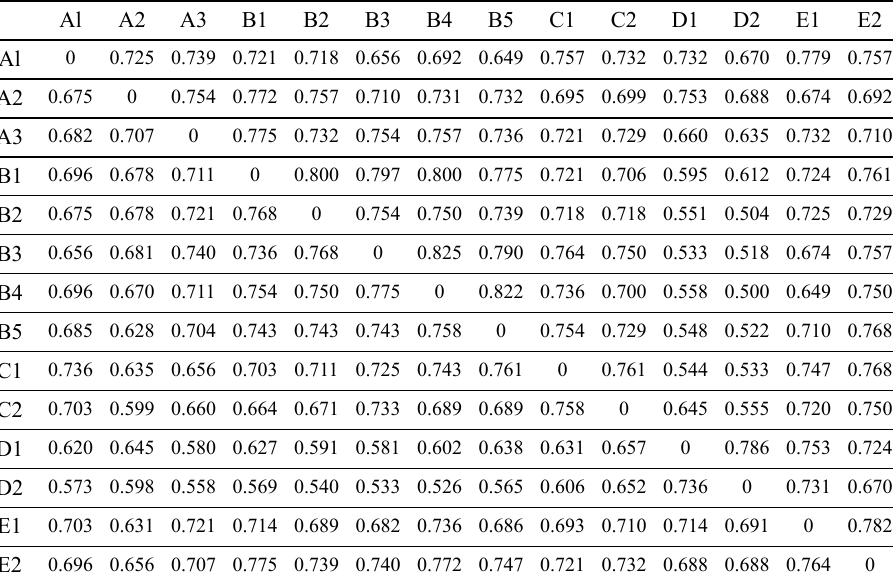
Table 7. The average initial direct-relation matrix A